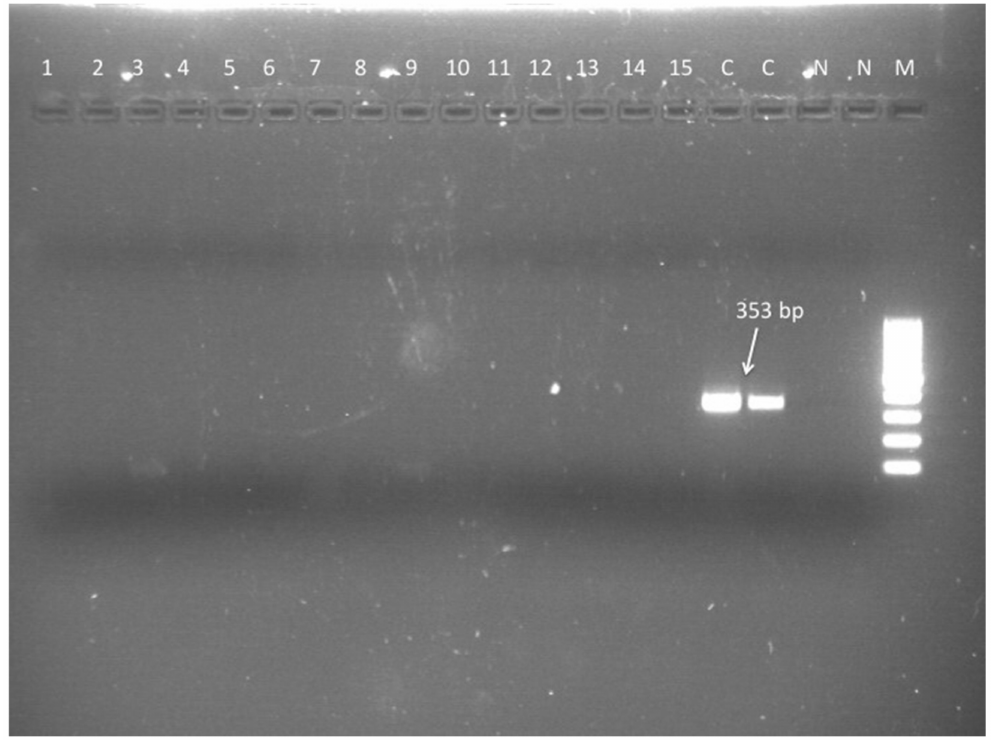
Figure 2. Leishmania genus specific nested-PCR for the diagnosis of L. infantum infection in dogs. Second nested amplification. M = molecular size marker (100–1000 bp). Lane 1 to 15 negative results (CSF DNA). Lanes C positive controls ( L. infantum DNA). Lanes N, negative controls (no